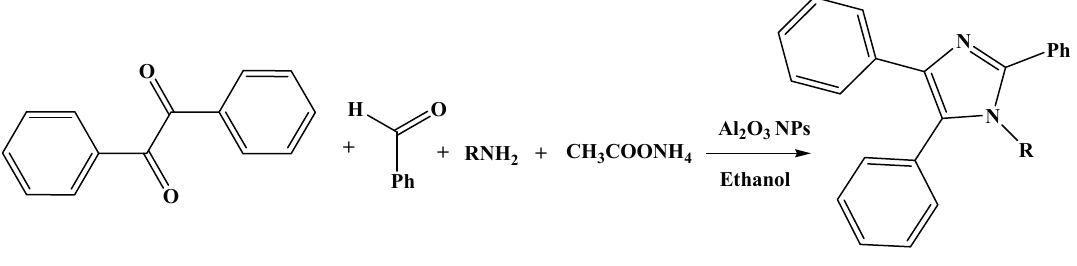
Figure 3. SEM micrographs of synthesized γ -Al 2 O 3 NPs at various magnifications.